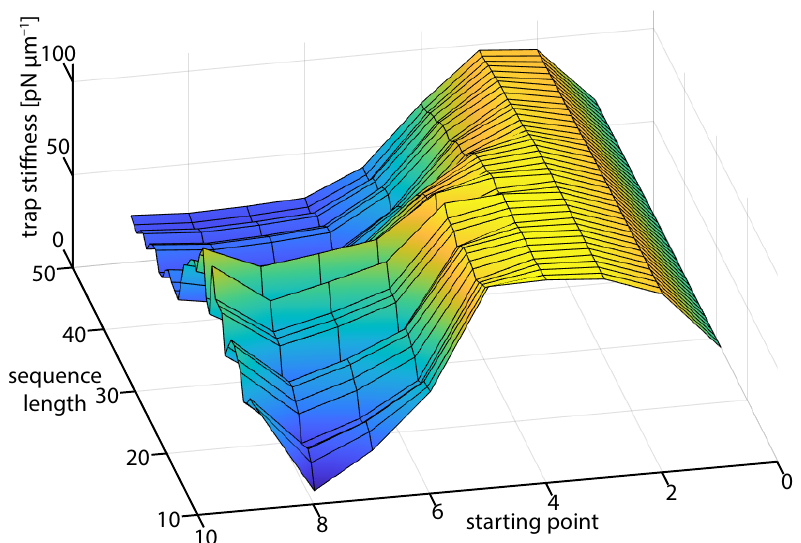
Figure 8. A surface graphic of the trap stiffness determined for particular starting points and duration (sequence length = duration of data capture/ ∆ t ) in the particle descent. The stiffness that is determined by FORMA is reduced by blurring of position data obtained near the